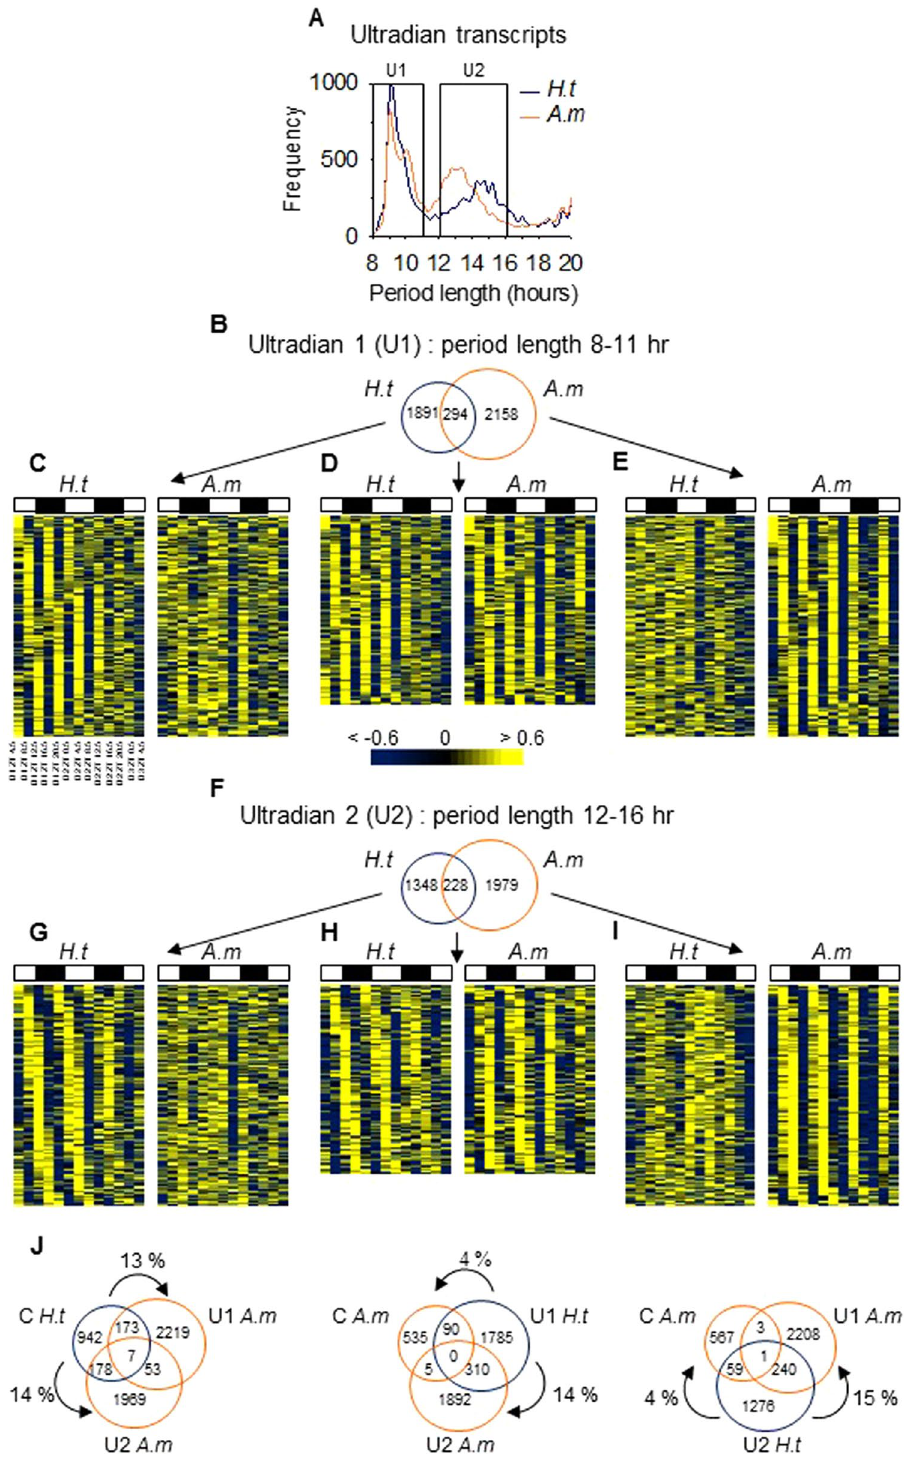
Figure 3. Discovery of an ultradian transcriptome remodeled with A. minutum exposure. ( A ) Period distribution of ultradian transcripts in H.t and A.m . ( B ) The number of U1 transcripts in H.t and A.m . ( C–E ) Heat maps of expression organized by phase for the 300 most significant U1 transcripts oscillating only in H.t ( C ), common in both ( D ), and only in A.m ( E ). ( F ) The number of U2 transcripts. ( G – I ) Heat maps of expression organized by phase for the 300 most significant U2 transcripts oscillating only in H.t ( G ), common in both ( H ), and only in A.m ( I ). ( J ) Venn diagrams of circadian ( C ), U1 and U2 transcripts in H.t and A.m